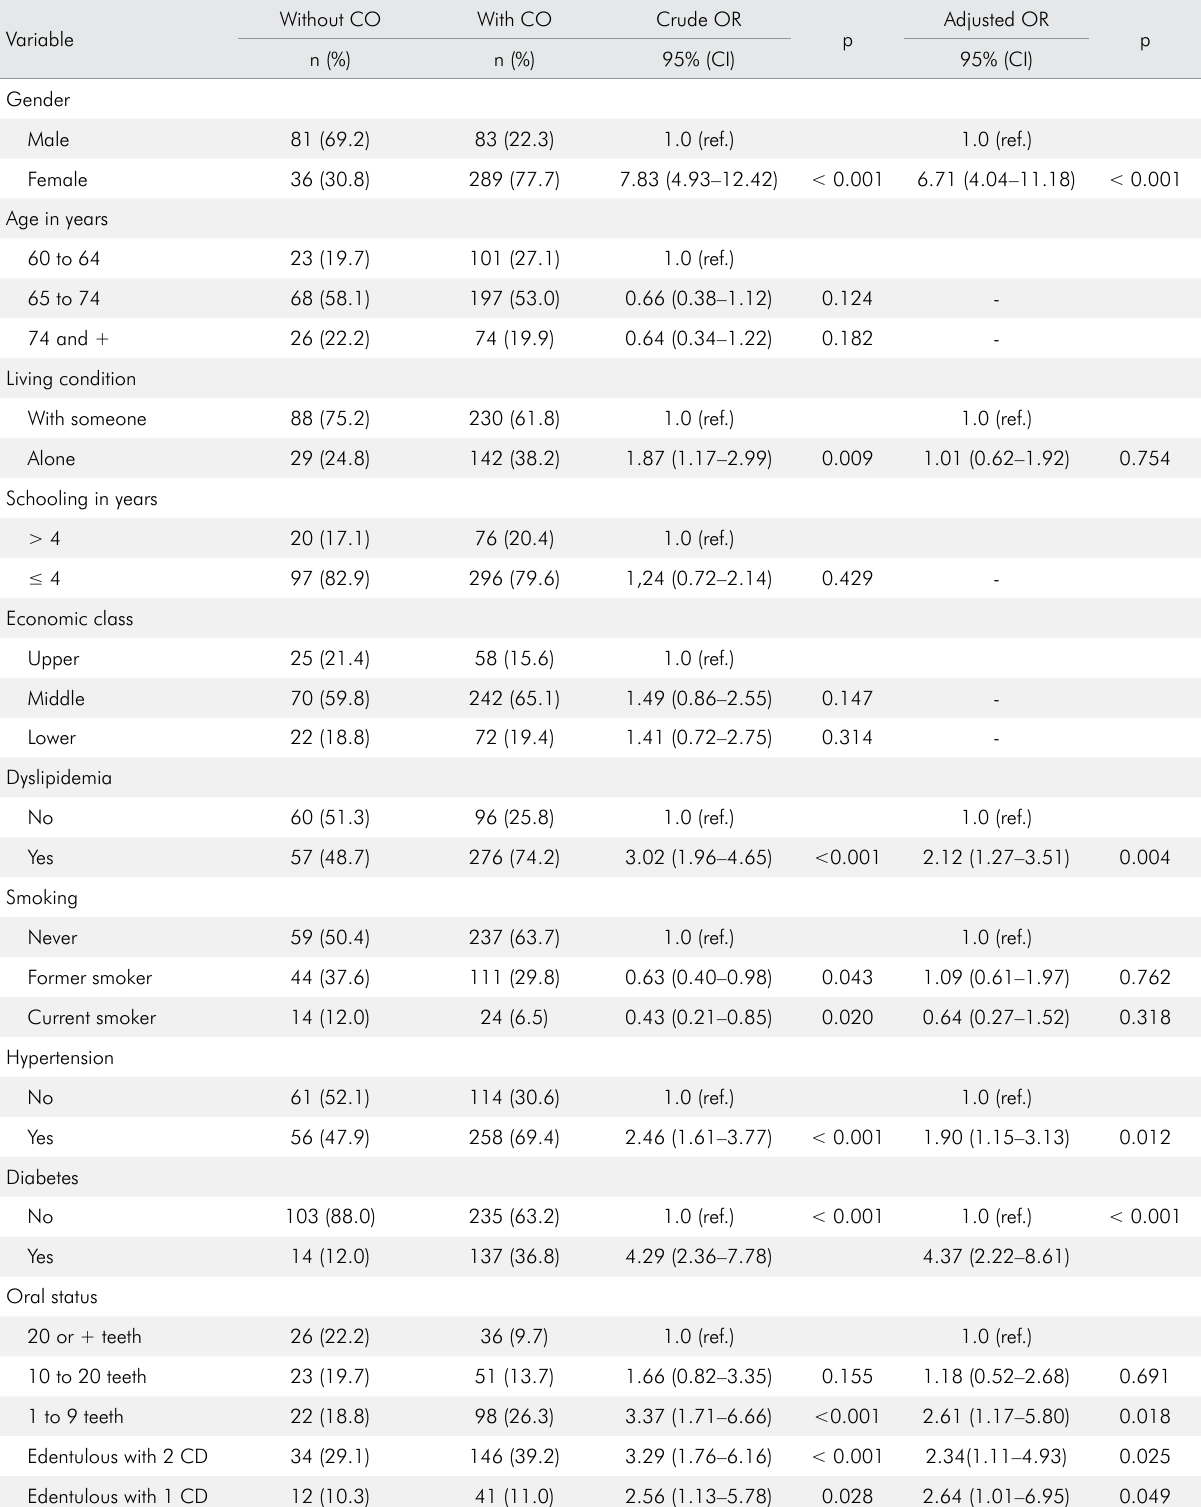
Table 2. Stepwise logistic regression between the independent variables and the presence of central obesity (CO), as established by waist-hip ratio(WHR) in the elderly (n=